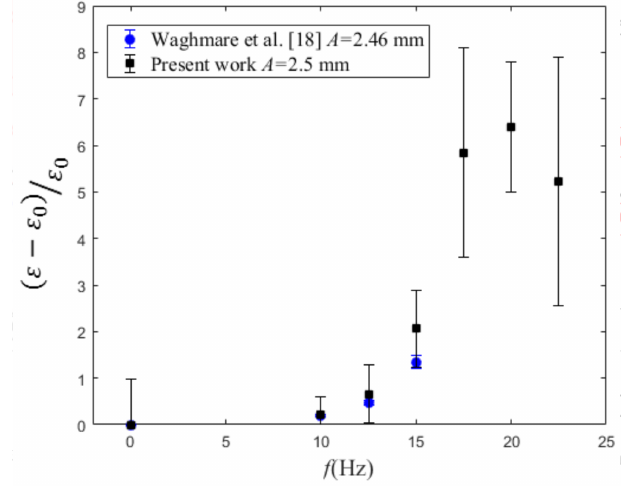
Figure 9. The void fraction ( ε ) scaled with the static column void fraction ( ε 0 ) plotted versus the vibration frequency ( U SG = 2.5 mm/s). The current results are compared with that of Waghmare et al. [18].